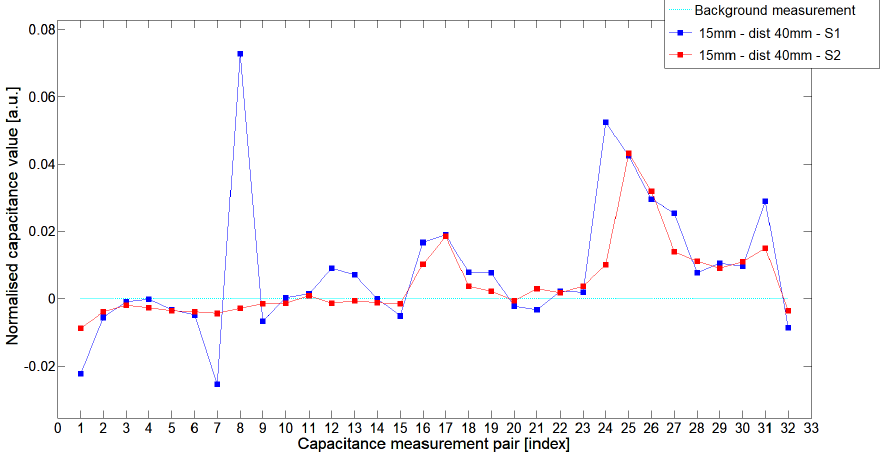
Figure 19. The 1st electrode measurement cycle (S1: 1->32 and S2: 1->32) for Test15 P 2 and S1—blue line, S2—red line. Cyan line indicates lower calibration